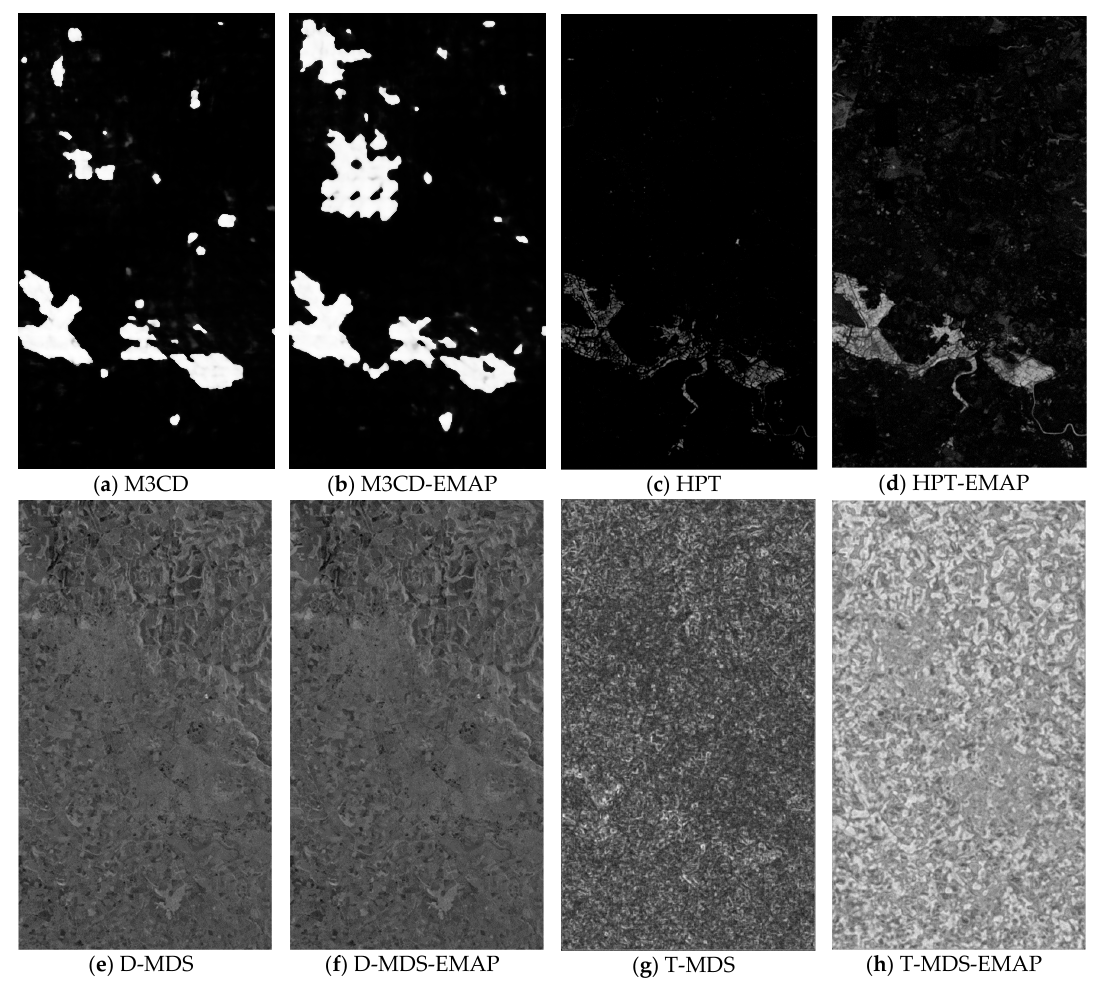
Table 4. AUC values and differences between single band and EMAP cases for dataset-3. Bold numbers indicate the best performing method in each column.